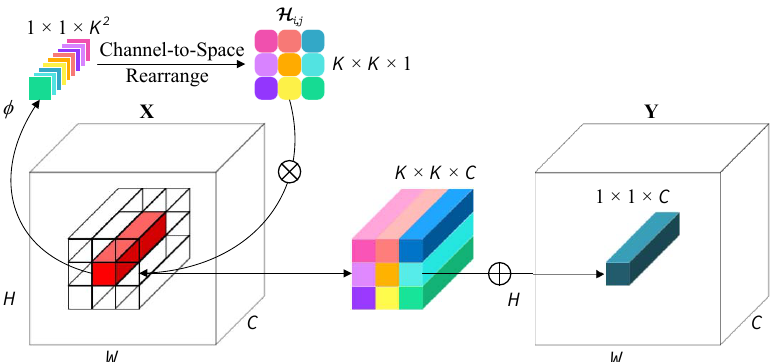
Figure 4. Illustration of the involution. The involution kernel H i , j ∈ R K × K × G is generated from the function φ conditioned on a single spectral feature vector at ( i , j ) . For ease of demonstration, group number G is set to be 1, which means that H i , j is shared among all the channels in this example. (cid:78) indicates multiplication broadcasting across C channels. (cid:76) refers to the summation operation, which aggregates features within the K × K spatial